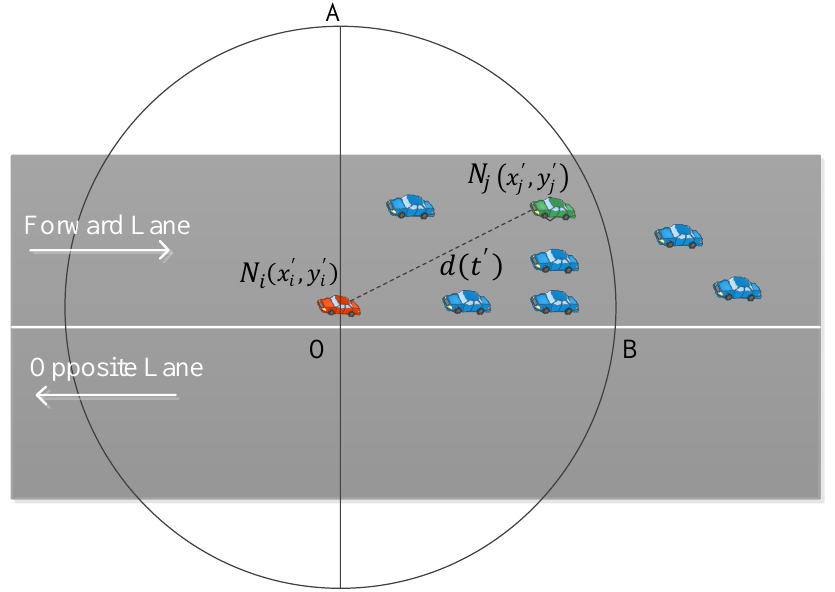
Figure 3. Selection of a vehicle for transmission.